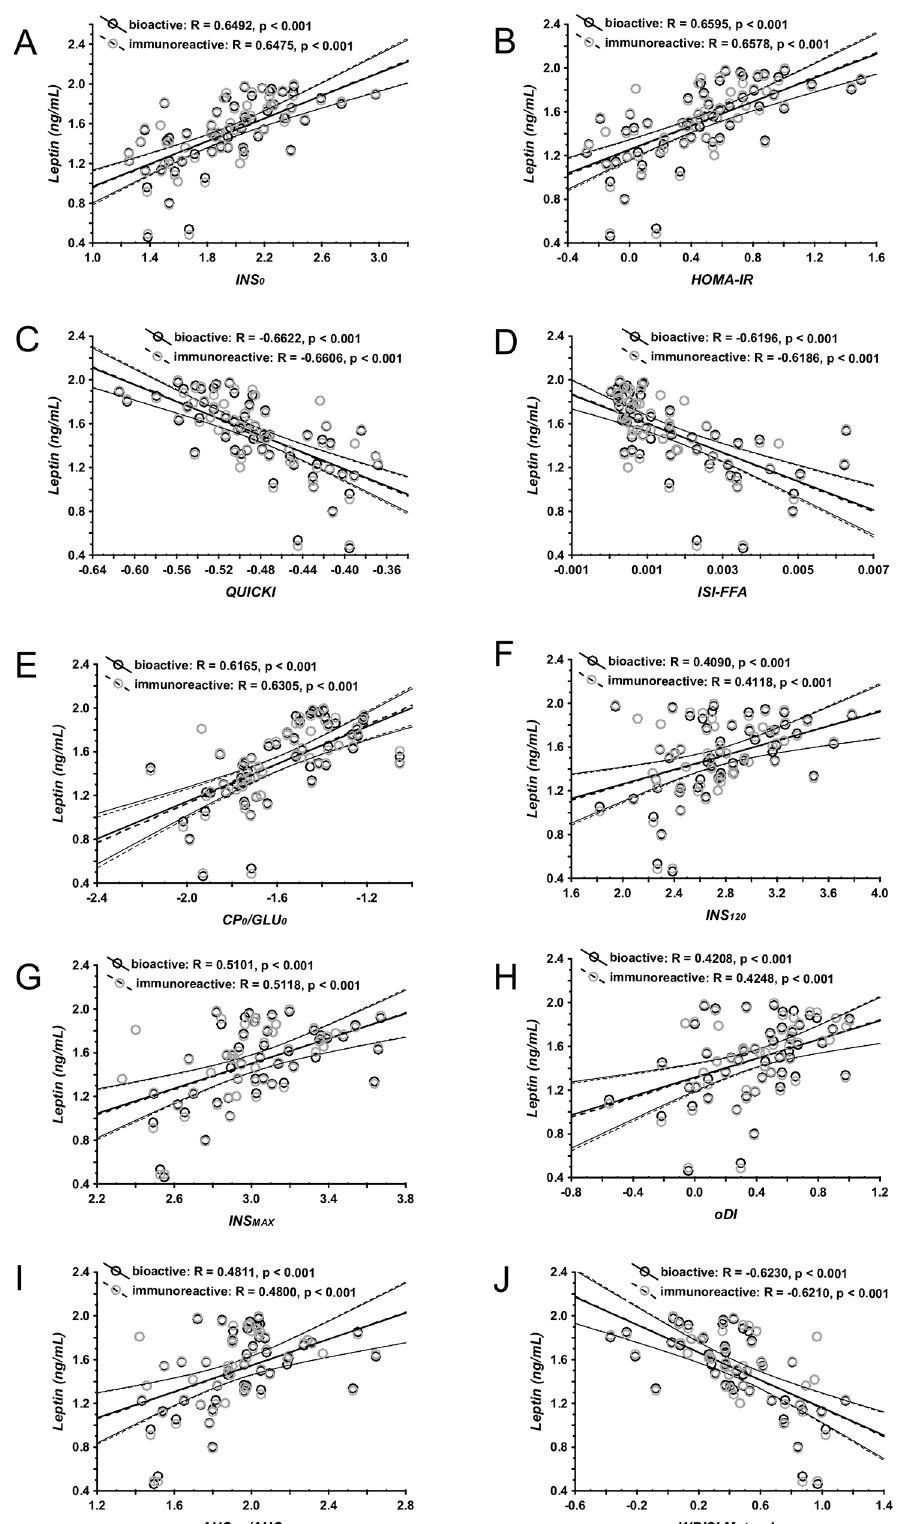
Fig 2. Correlation between bioactive and immunoreactive leptin levels with selected indices of insulin secretion and insulin resistance. A—fasting serum insulin(logINS 0 ); B–HOMA-IR; C–QUICKI; D–free fatty